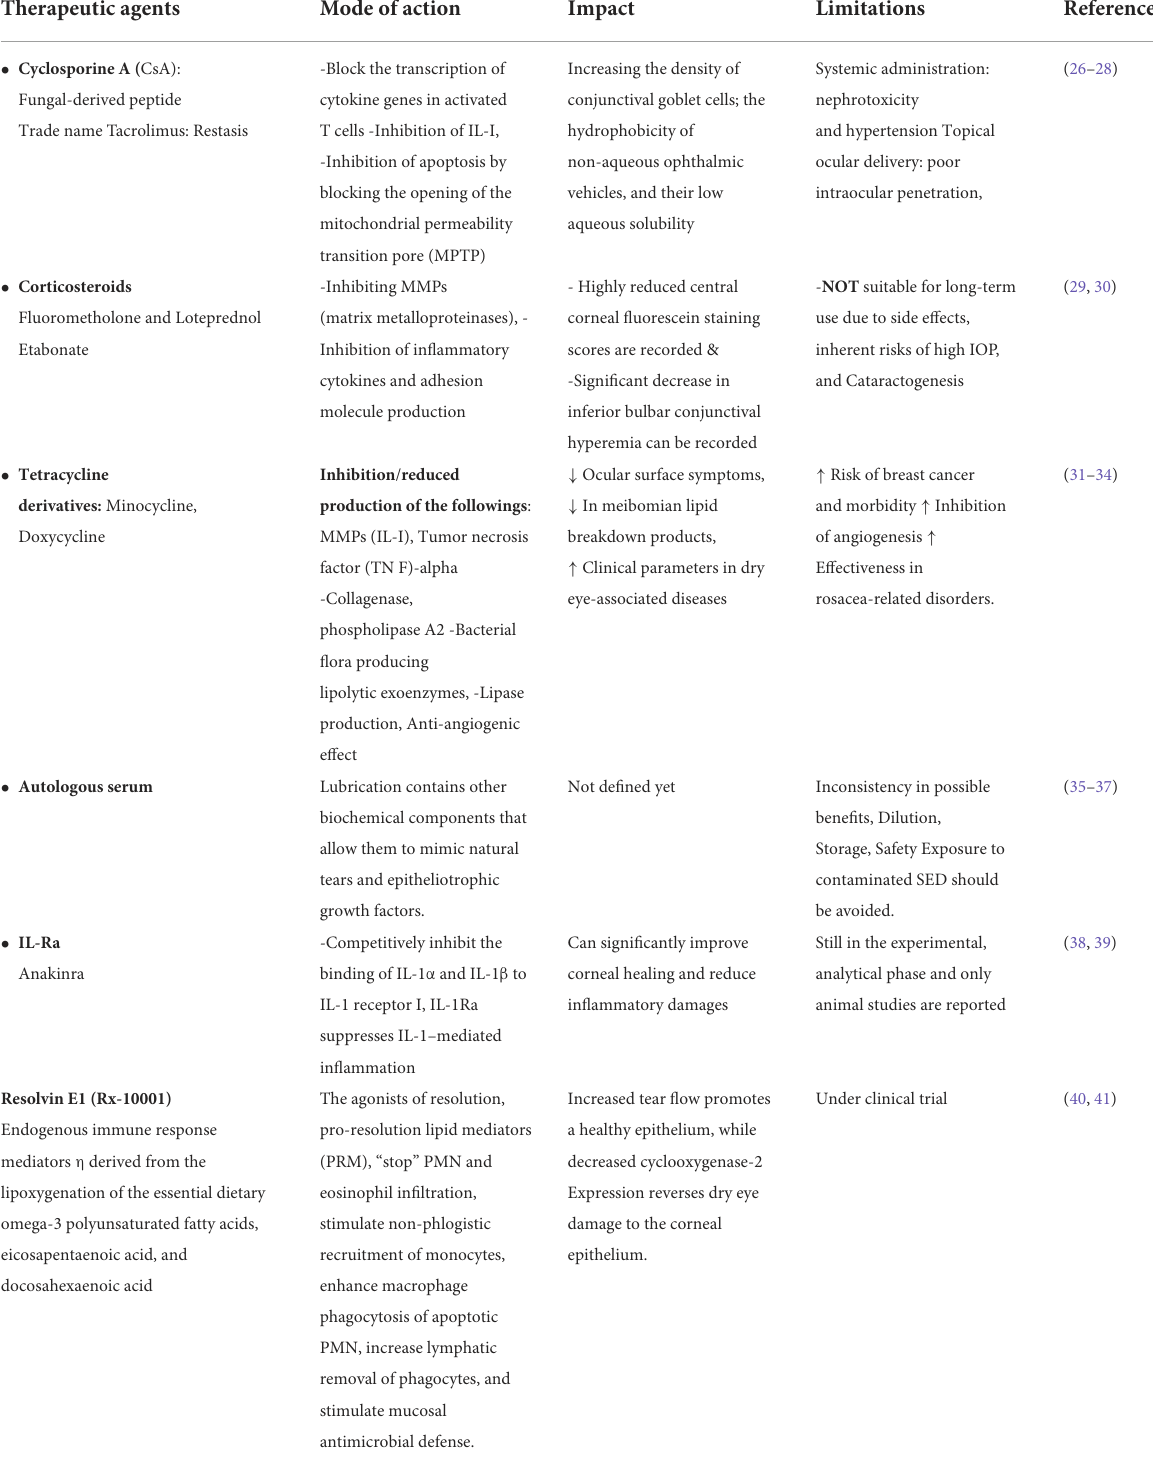
TABLE 2 Therapeutic agents for dry